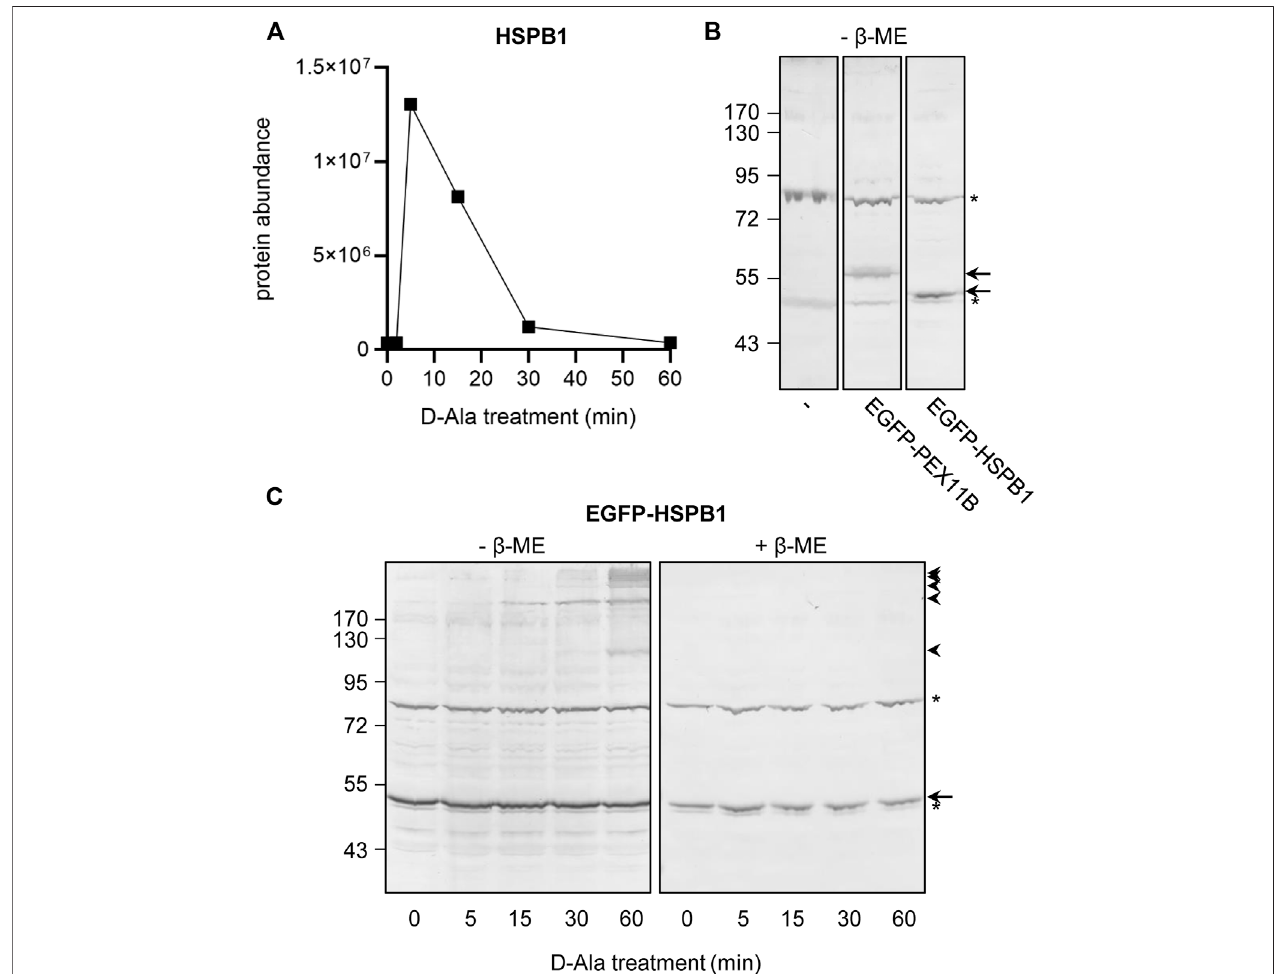
FIGURE 9 | Sulfenylation and disul fi de bond formation kinetics of HSPB1 in response to peroxisomal H 2 O 2 production. Flp-In T-REx 293 cells expressing po-DD- DAOandcontainingc-IBD-SBP-YAP1C (A) ornot (B,C) weretransfected (B,C) ornot (A) withaplasmidencodingnoEGFP-fusionprotein( − ),EGFP-PEX11B,orEGFP- HSPB1. The cells were incubated in DPBS containing 10 mM 3-AT and 10 mM D-Ala. At the indicated time points, the cells were processed asdetailed in the legend of (A) Figure 5 , or (B,C) processed for SDS-PAGE under non-reducing (- β -ME) or reducing (+ β -ME) conditions and subsequently subjected to immunoblot analysis with antibodies speci fi c for EGFP. The migration points of relevant molecular mass markers (expressed in kDa) are shown on the left. The arrows and arrowheads mark the non-modi fi ed and oxidatively modi fi ed proteins, respectively. Note that panel B was included to document the non-speci fi c immunoreactive bands (marked by asterisks) of the anti-EGFP